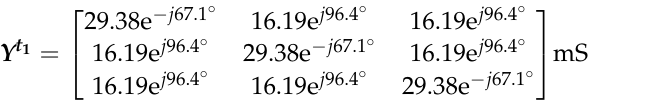
The odd and even mode admittances at the reference plane t 1 can be calculated by substituting the entries of the admittance matrix into Equation (4):